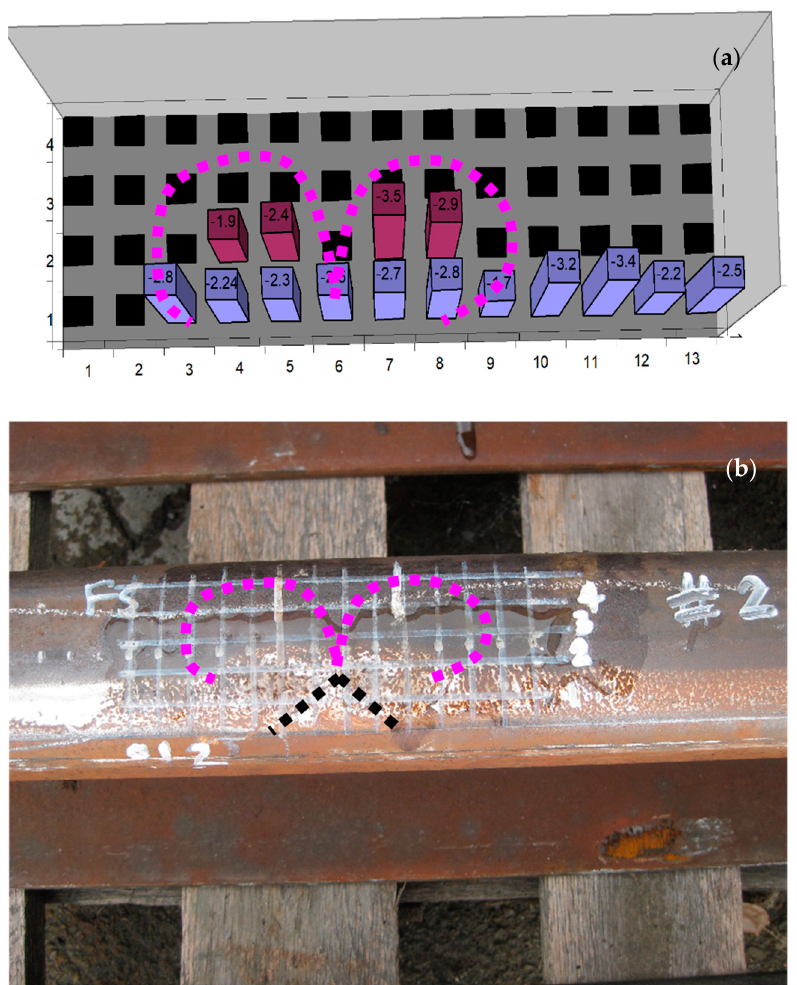
Figure 12. An ultrasonic rail squat measurement: ( a ) crack depths at each grid point; ( b ) top view of the rail surface.